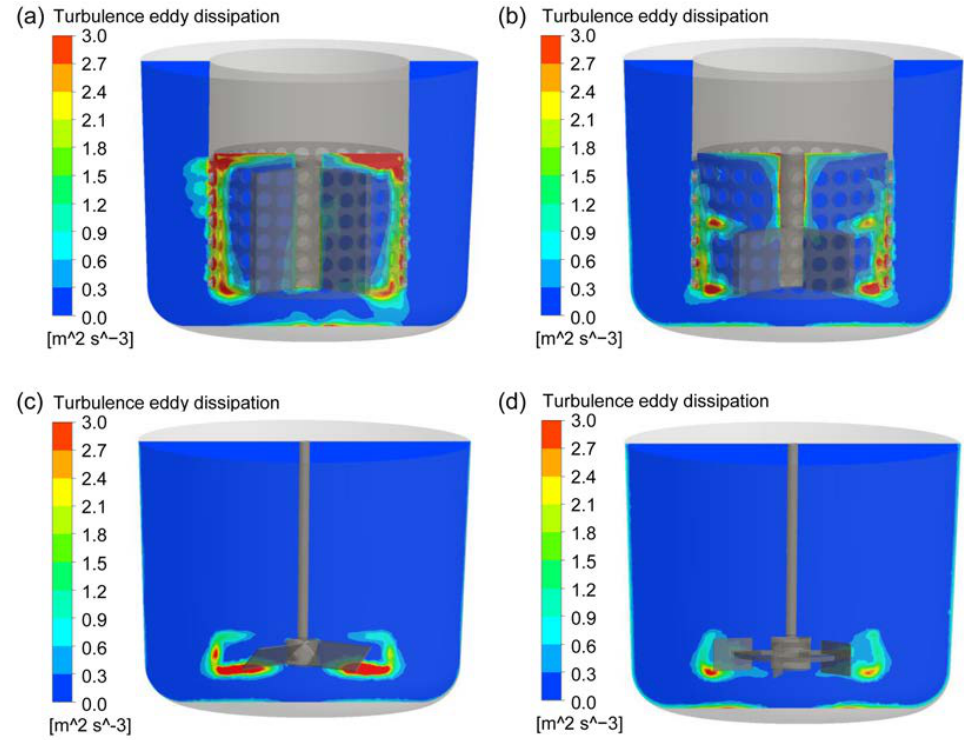
Figure 8. The distribution of turbulent energy dissipation rate on the vertival plane at the stirring speed of 400 rpm for the four types of agitators; ( a ) CSRS agitator; ( b ) HCSRS agitator; ( c ) A200 agitator; ( d ) Rushton agitator.